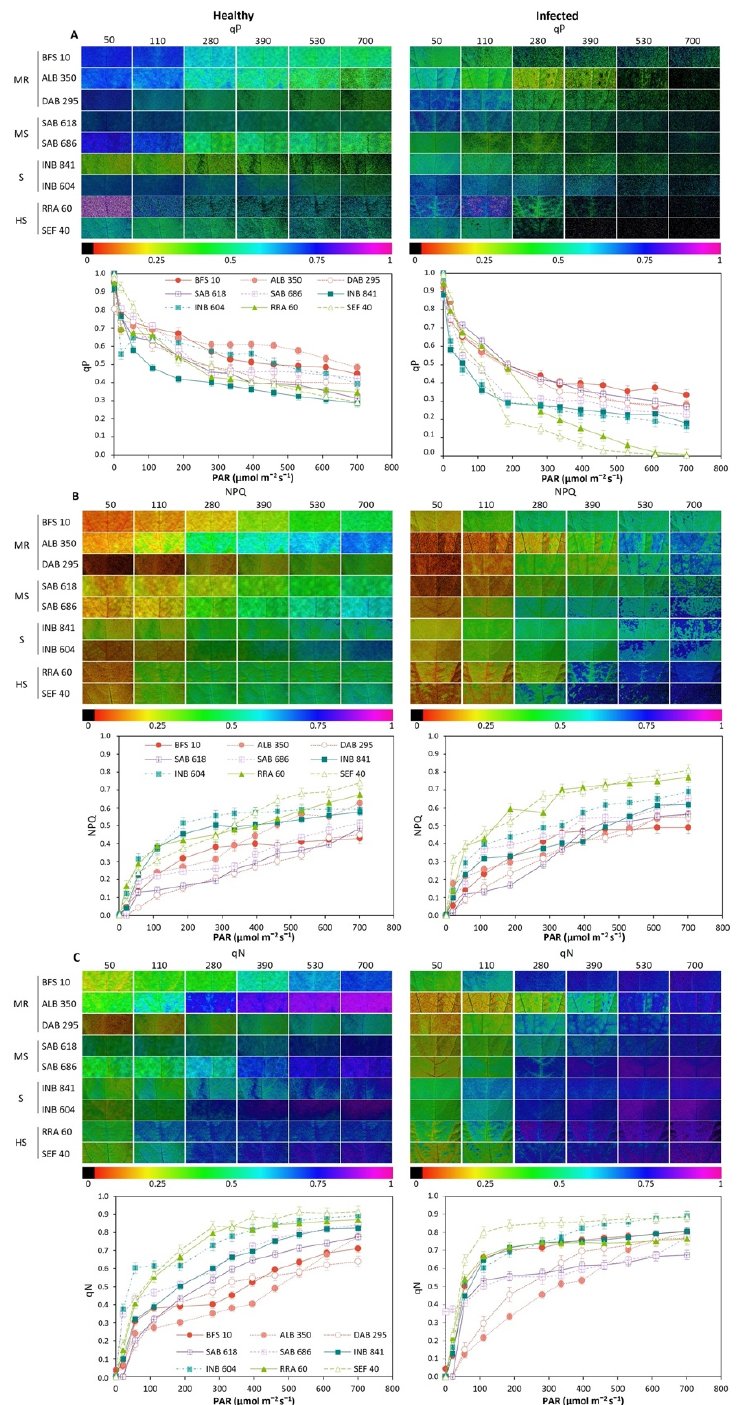
Figure 8. Response to disease stress as a function of the photosynthetically active radiation (PAR) level of common bean lines conforming different typologies. BSF 10, ALB 350, DAB 295: moderately